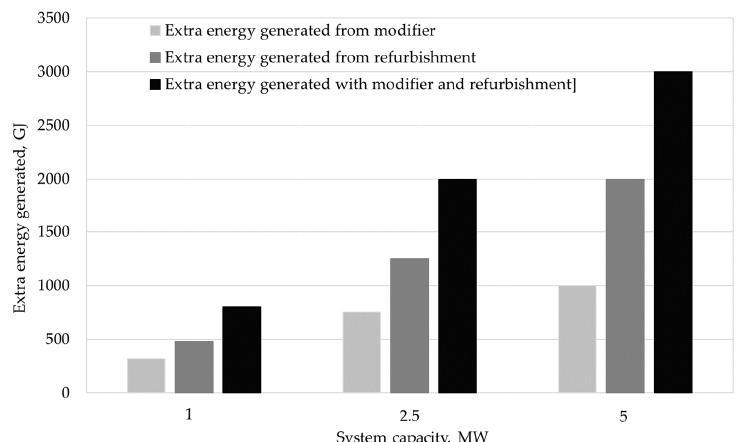
Figure 3. The extra energy effect of using the modifier and refurbishment for system capacities from 1 MW to 5